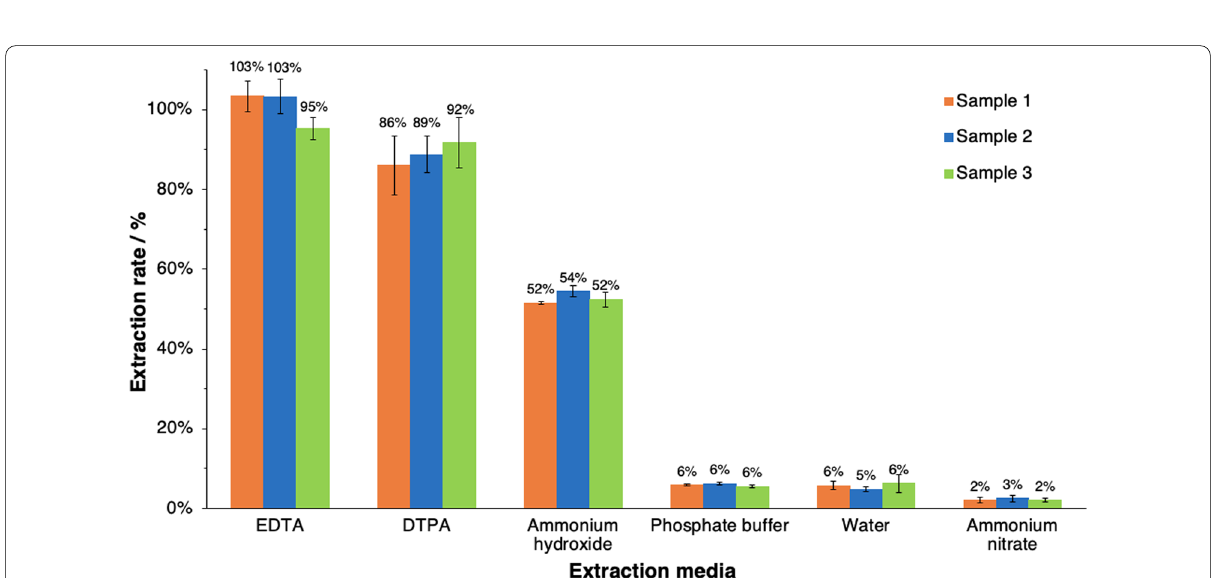
Fig. 2 Summary of extraction rates of six different pretreatment methods (3 samples per